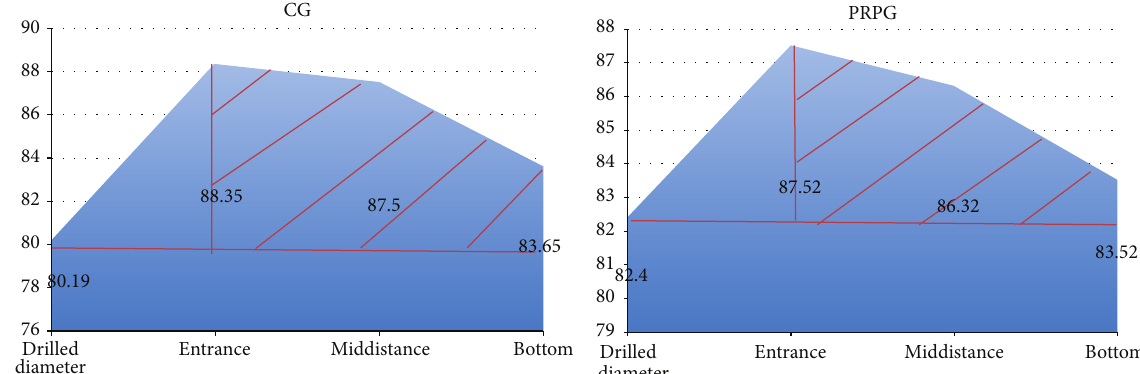
Figure 5: CG mean tunnel dilation at the entrance, middistance, and bottom end of the tunnel at 12 months. Horizontal red line shows the mean drilled diameter and shadowed area demonstrates the shape of tunnel dilation (conical). PRPG mean tunnel dilation at the entrance, middistance,andbottomendofthetunnelat12months.Horizontalredlineshowsthemeandrilleddiameterandshadowedareademonstrates the shape of tunnel dilation